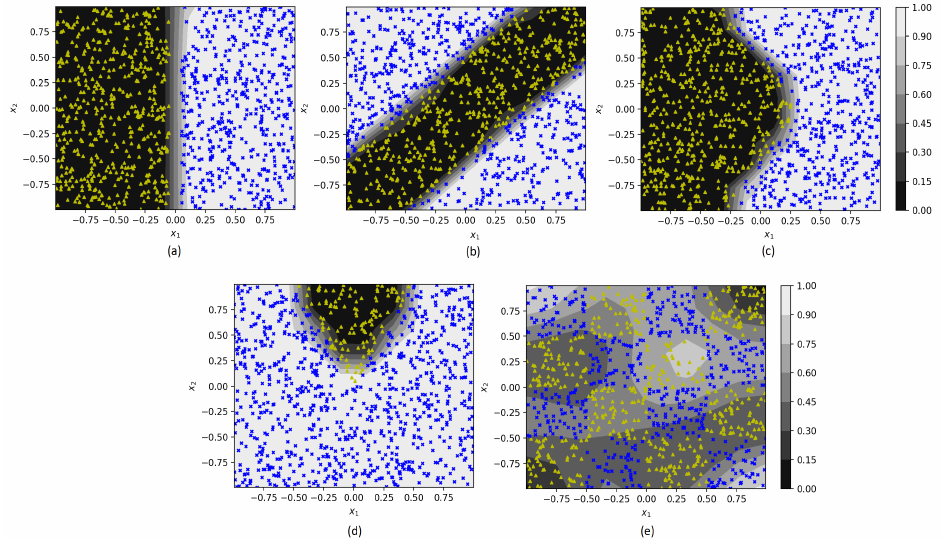
Figure 4. Five synthetic datasets and the boundaries between classes provided by SVM in the form of: ( a ) the linear separation; ( b ) a stripe; ( c ) a saw-based separating function; ( d ) a wedge; ( e ) the checkerboard